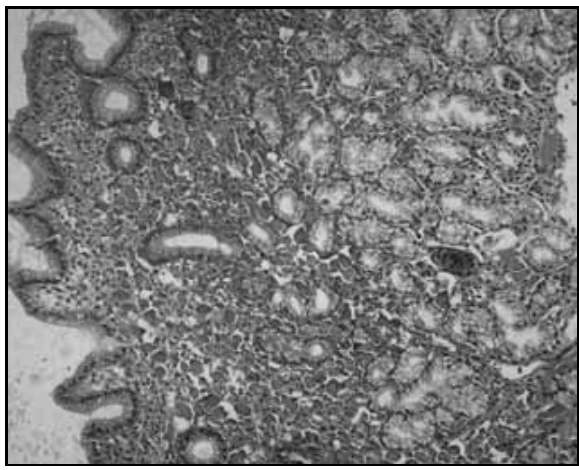
Figure 1 – Gastric biopsy showing a moderate mononuclear inflammatory infiltrate in the lamina propria with predominance of plasma cells, hematoxylin-eosin,